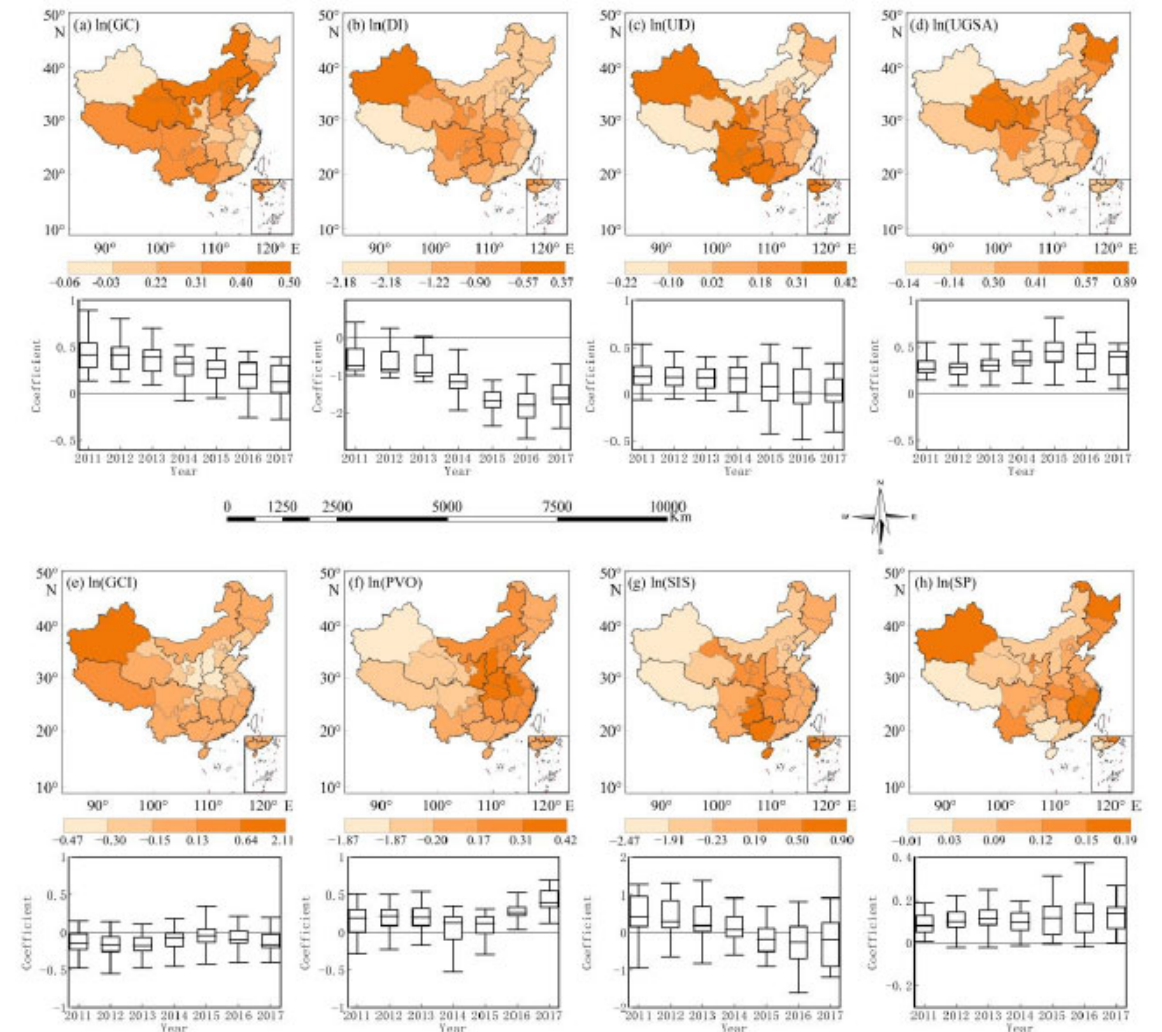
Figure 6. Spatial distribution and temporal variation in various coefficients of NO x in the geographically and temporally weighted regression (GTWR) model.